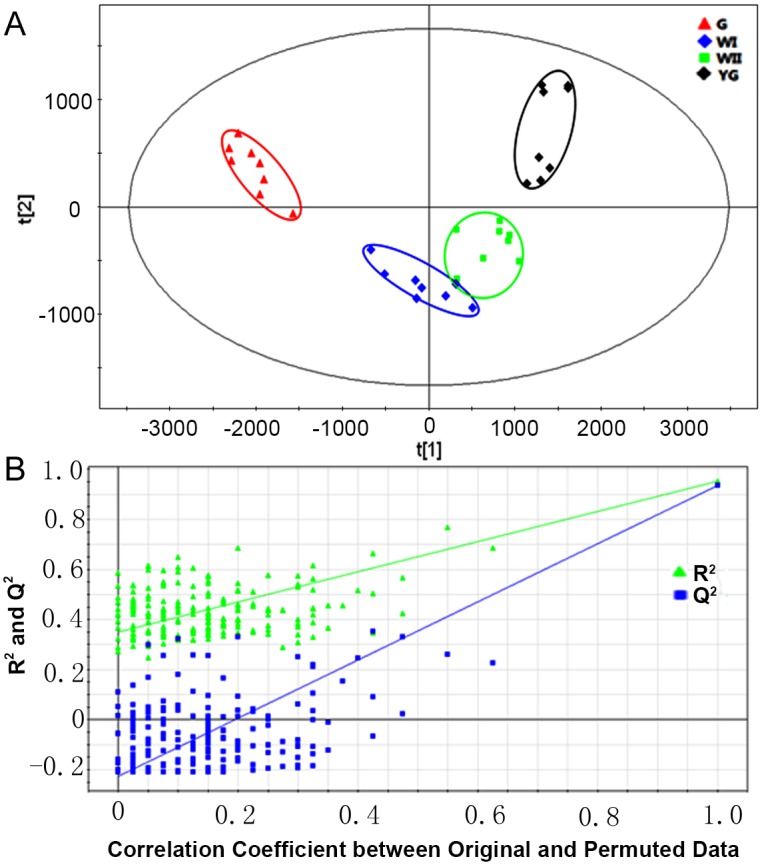
PLS-DA score scatter plots and permutation tests.(A) PLS-DA score plots resulted from the metabolites in tea plant leaves in the three different albescent stages (YG, WI and WII) and the G stage. The sampling groups are color coded as follows: black = YG-stage leaves; blue = WI-stage leaves; green = WII-stage leaves; and red = G-stage leaves. (B) Permutation tests of the PLS-DA model indicate the absence of over-fitting in the model.